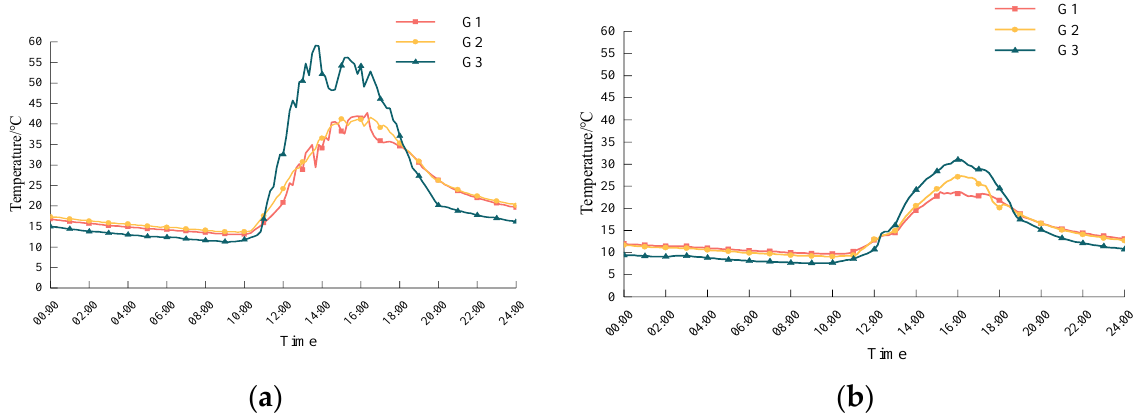
Figure 8. Wall surface temperature variation of CSGs under typical weather. ( a ) Sunny day (20 February 2022). ( b ) Cloudy day (18 February 2022).